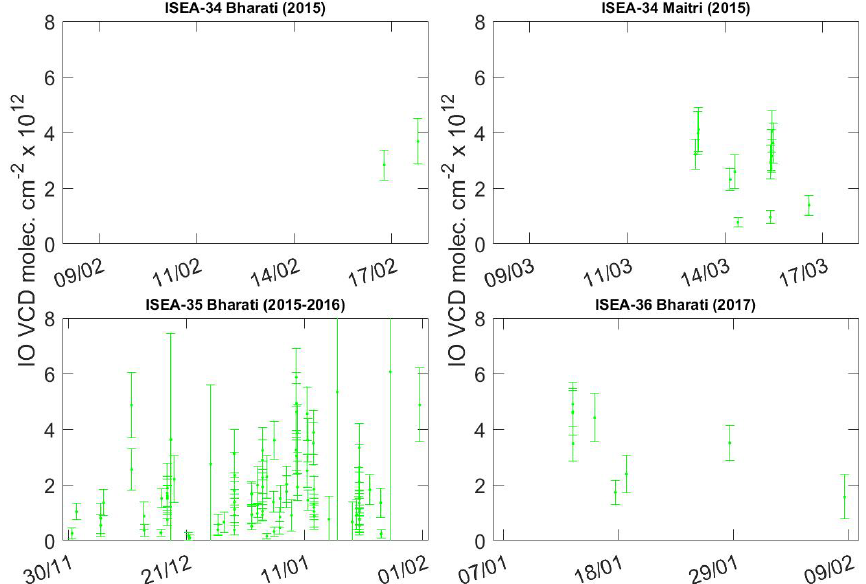
Figure 7. Observations of IO vertical column densities observed throughout all four campaigns are shown. These data were mostly during periods of clear sky and where IO was observed above the detection limit for most of the set elevation angles, enabling a reliable profile retrieval.